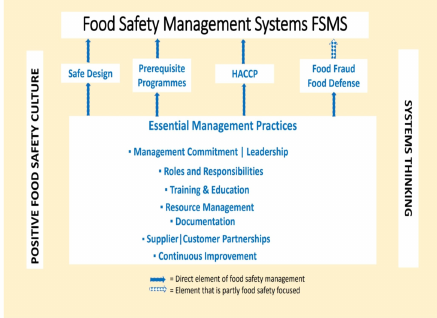
Figure 3. The interaction between FSMS, necessary good management practices, positive food safety culture and systems thinking Source: (Adapted from “Food Safety for the 21st Century”, Figure 9.2, page 164)